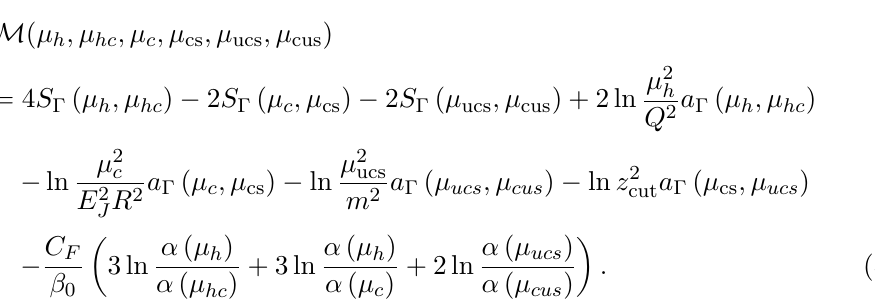
Figure 10 . Comparison between ungroomed and groomed jet cross sections of top quark jets in electron-positron collisions. The black (blue) bands are groomed (ungroomed) jets with resumma- tion with NLL 0 accuracy, and the black (blue) dotted curves are groomed (ungroomed) jets with the fixed order NLO calculation. (a), (b), and (c) correspond to different jet radii, R = 0 . 2 , 0 . 4 , and 0 . 6 , respectively. The center of mass energy is Q = 4 TeV and the jet energy is E J = Q/ 2 = 2 TeV. where η = 2 a ( µ , µ ) and the RG evolution factor M cus Γ hc